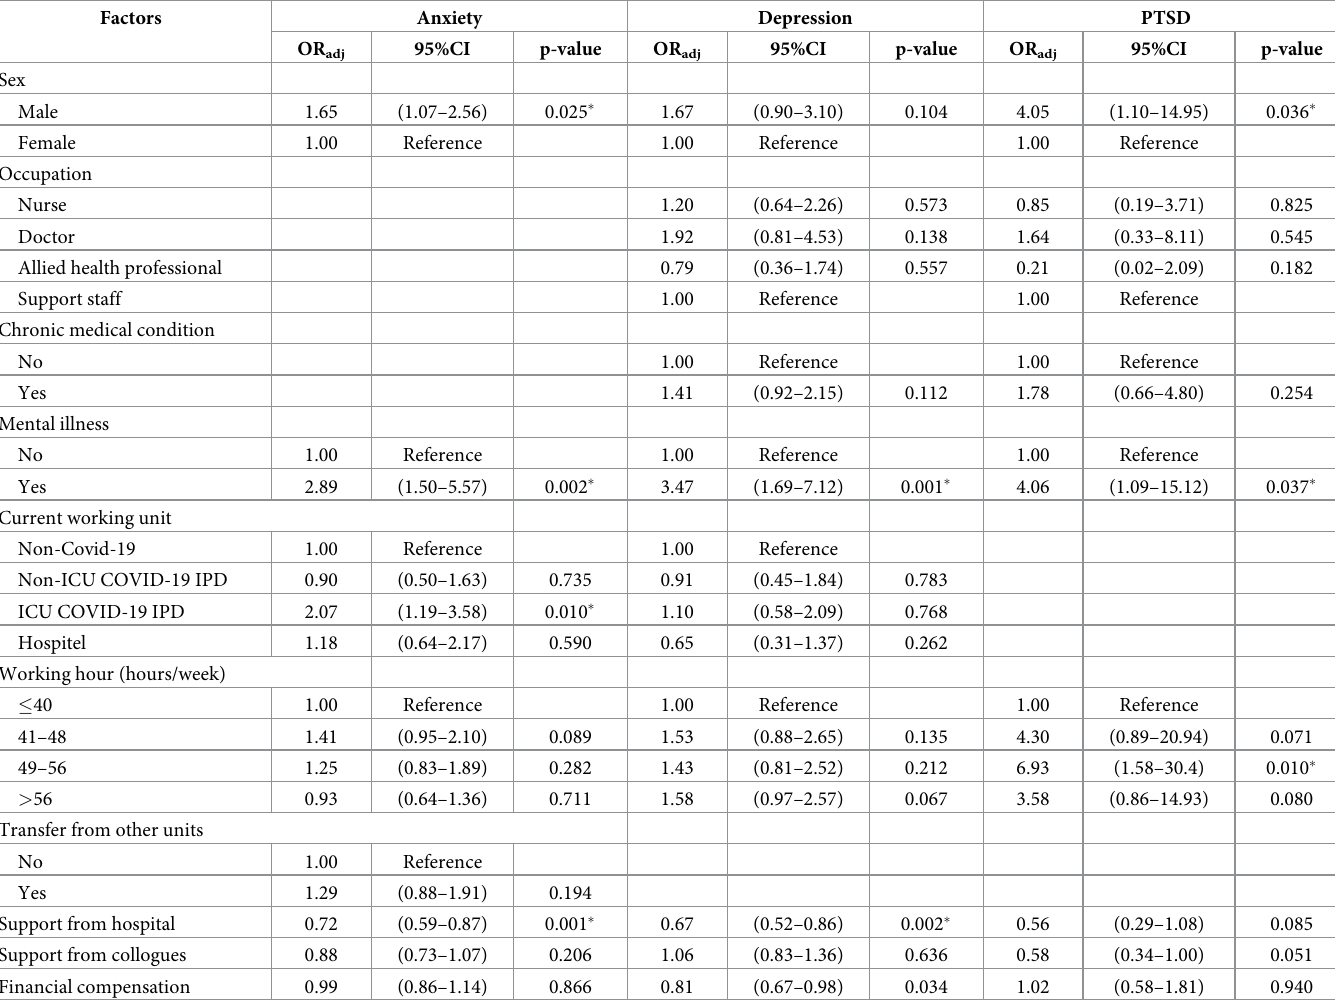
Table 4. Adjusted odds ratios from multivariable analysis of the associated factors of anxiety, depression, and PTSD among